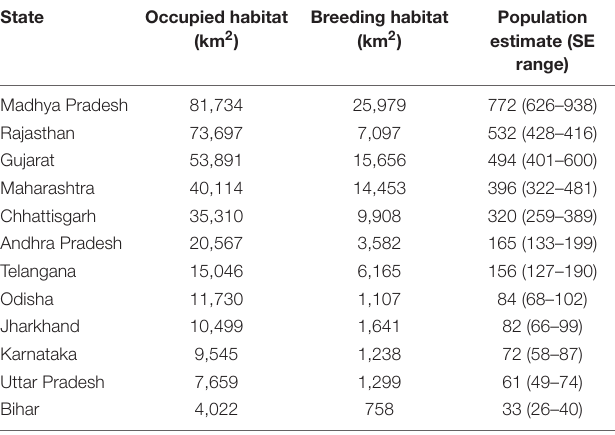
TABLE 1 | State-wise estimated wolf population based on the MaxEnt model estimate of potential occupied, breeding habitat, average pack size of 3 (SE 0.24), and territory size of 188 (SE 23) km 2